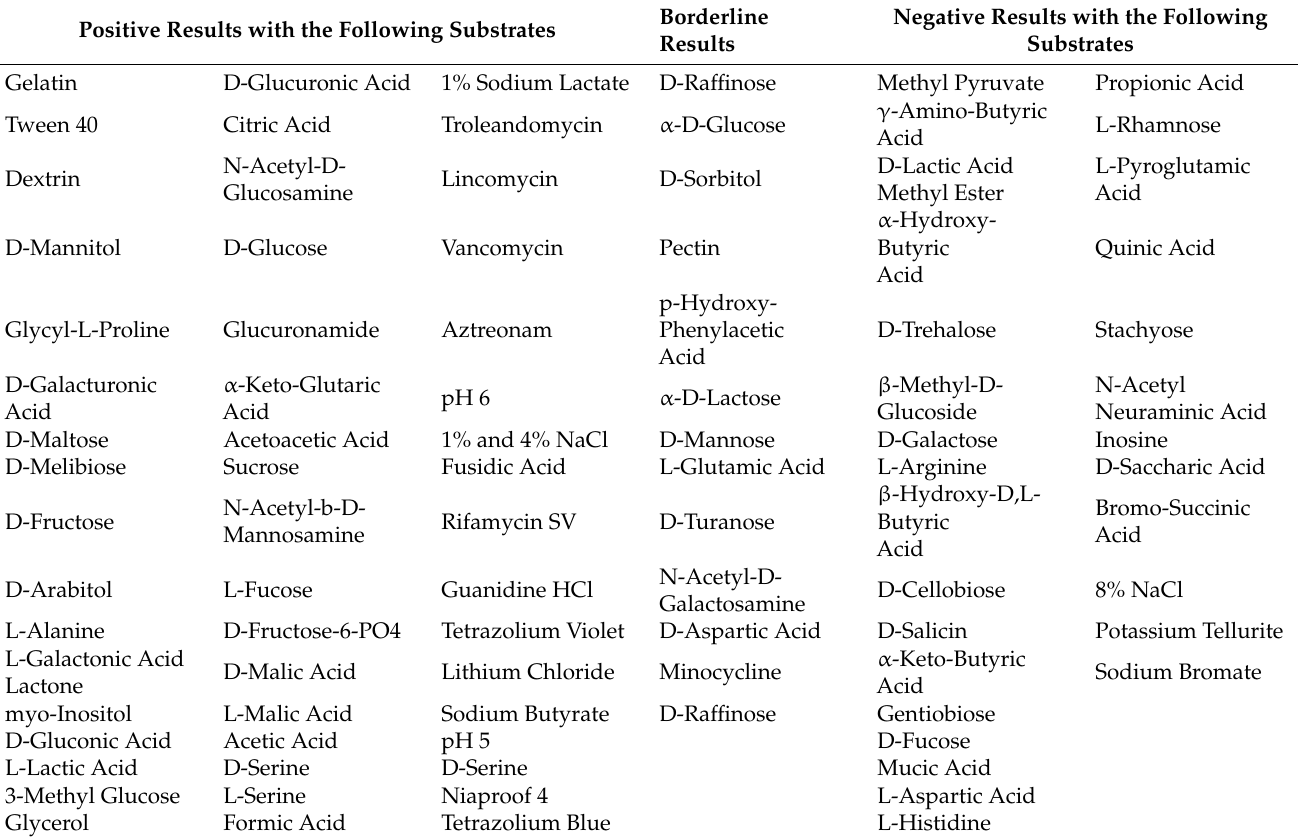
Table 2. Biochemical characterization of strain MDK33 based on Biolog Gen III